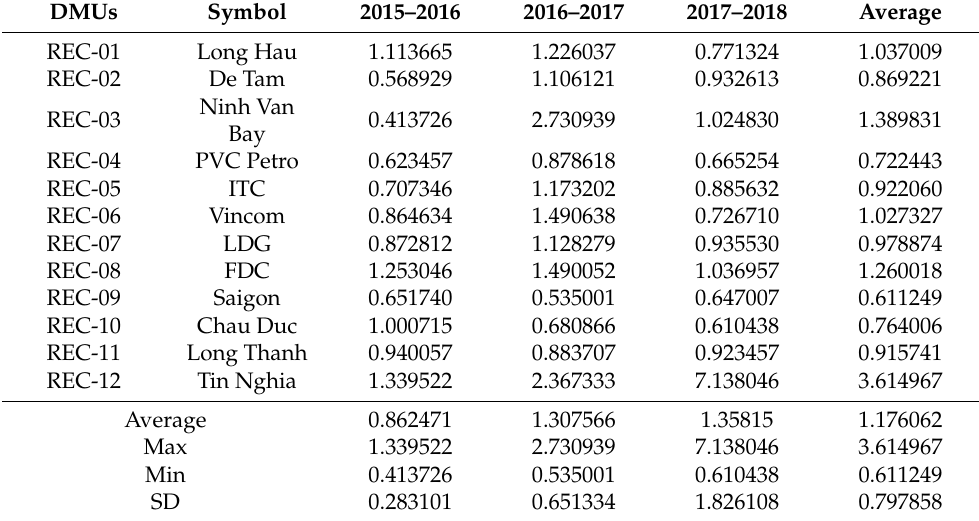
Table 7. Catch-up index